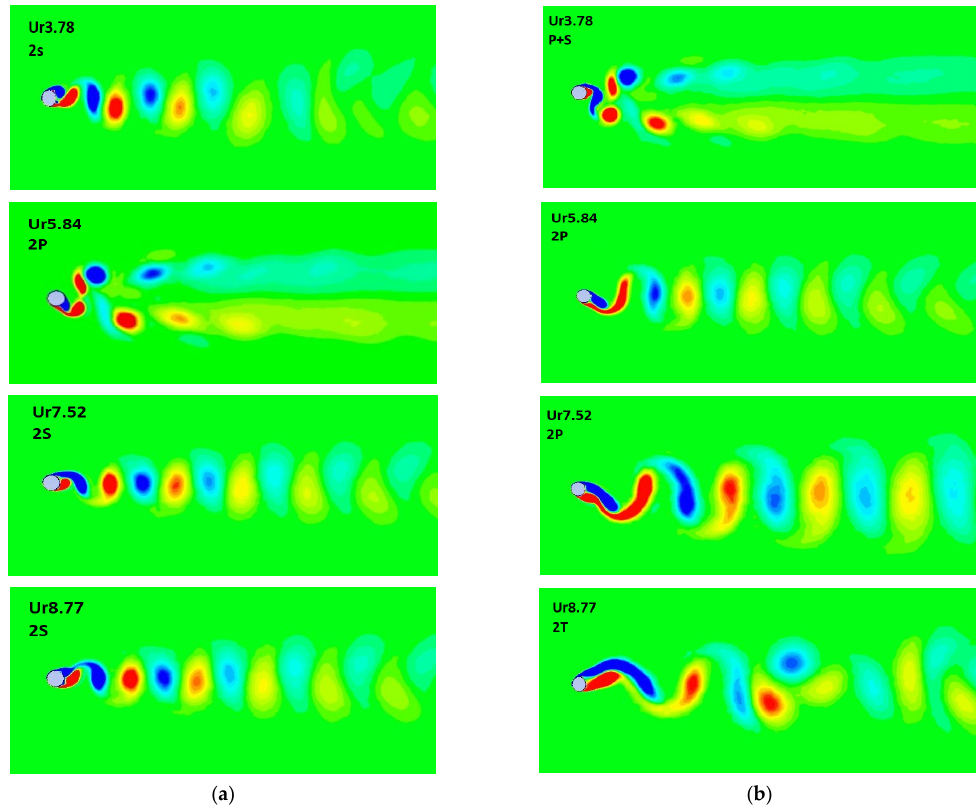
Figure 5. Vortex mode at different reduced velocity for mass ratio ( a ) m* = 11 and ( b ) m* = 2.4.